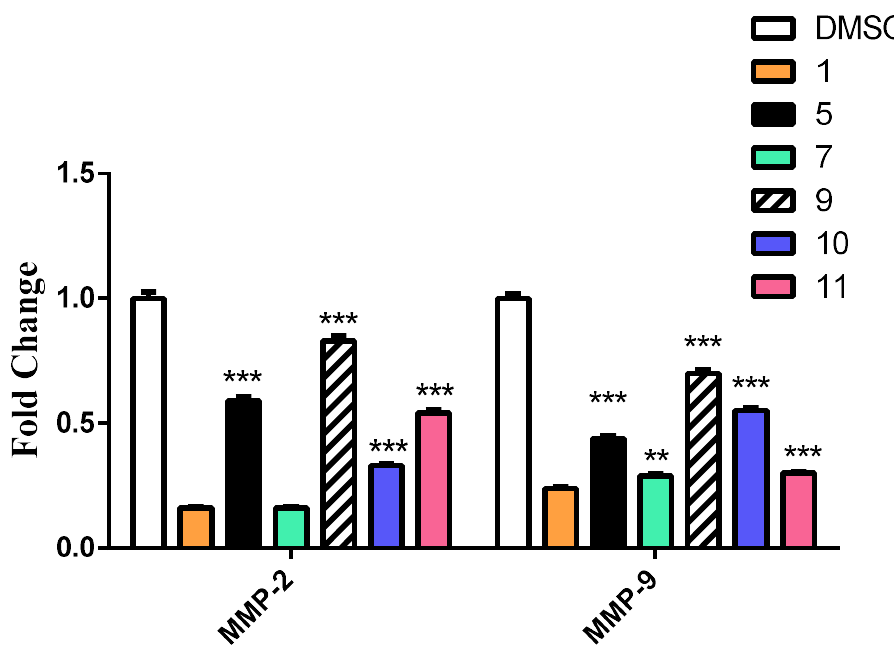
Figure 8. The effect of CA and its derivatives on the expression of MMP-2 and MMP-9 by RT-qPCR. The results were represented as mean of fold changes ± SD. β-actin gene was used as a control gene. ** Significant from CA at p < 0.01, *** Significant from CA at p < 0.001.